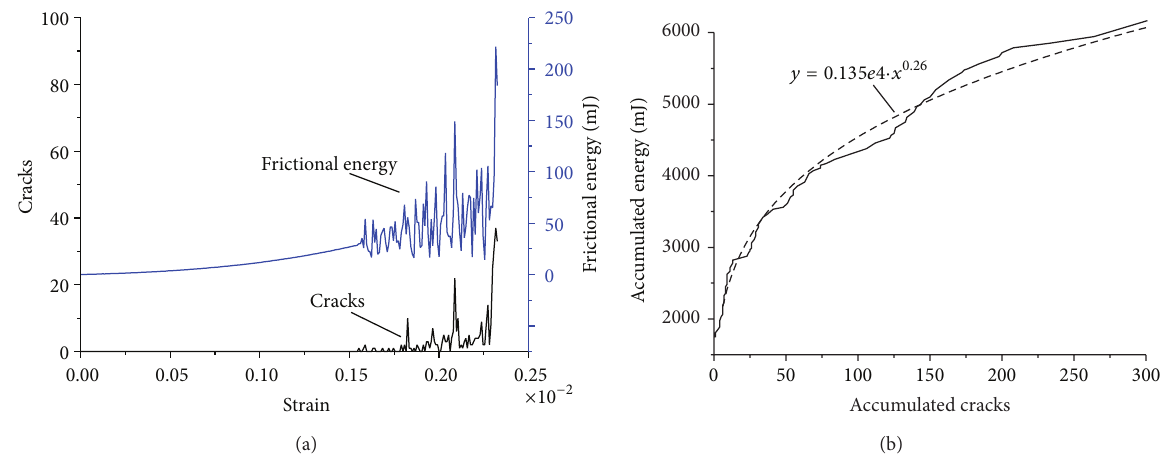
Figure 6: Relation curves of frictional energy and cracks. (a) Transient energy and cracks; (b) accumulated energy and cracks.